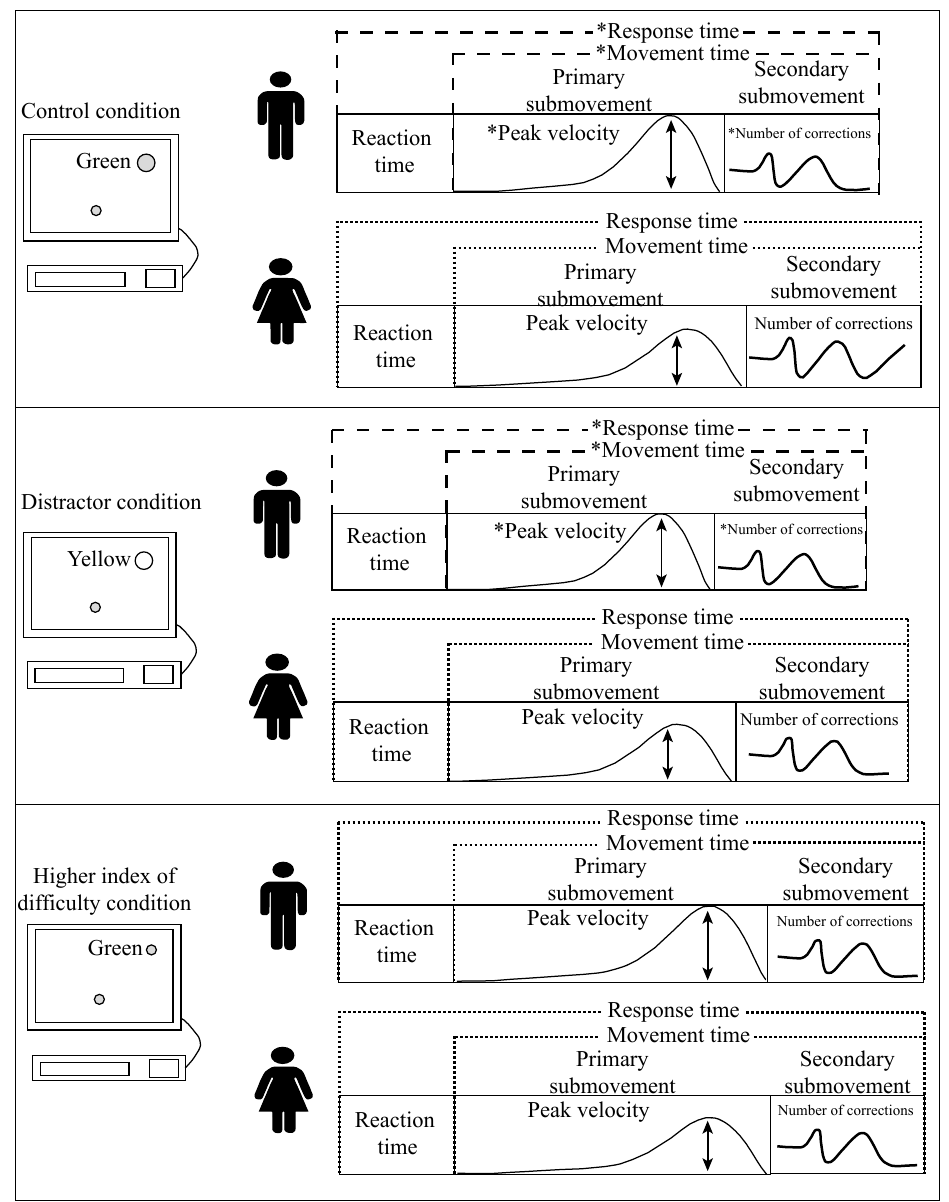
Figure 1. Graphical representation of the dependent variable behavior in the three conditions of execution; significant differences indicated by asterisks